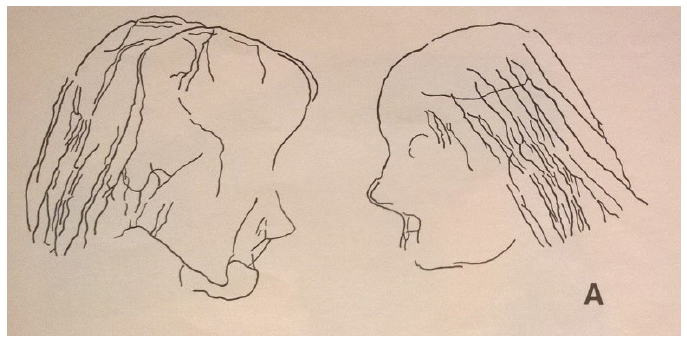
Figure 12. Group α, examples of Hand α3: Obs. 23(I-II) (from Pales, 1976).